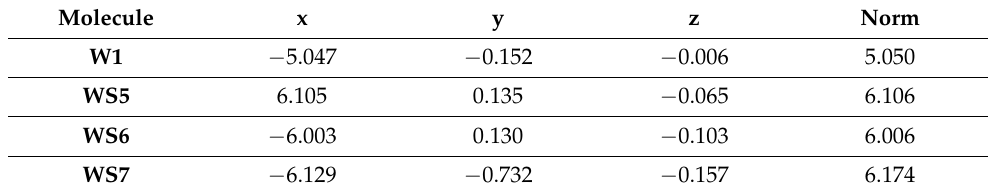
Table 2. Transition dipole moments of the excited state S1 of W1, WS5, WS6, and WS7 (a.u.).